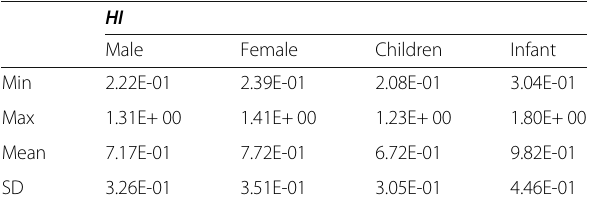
Table 4 Summary statistics of HI for NO 3 in the